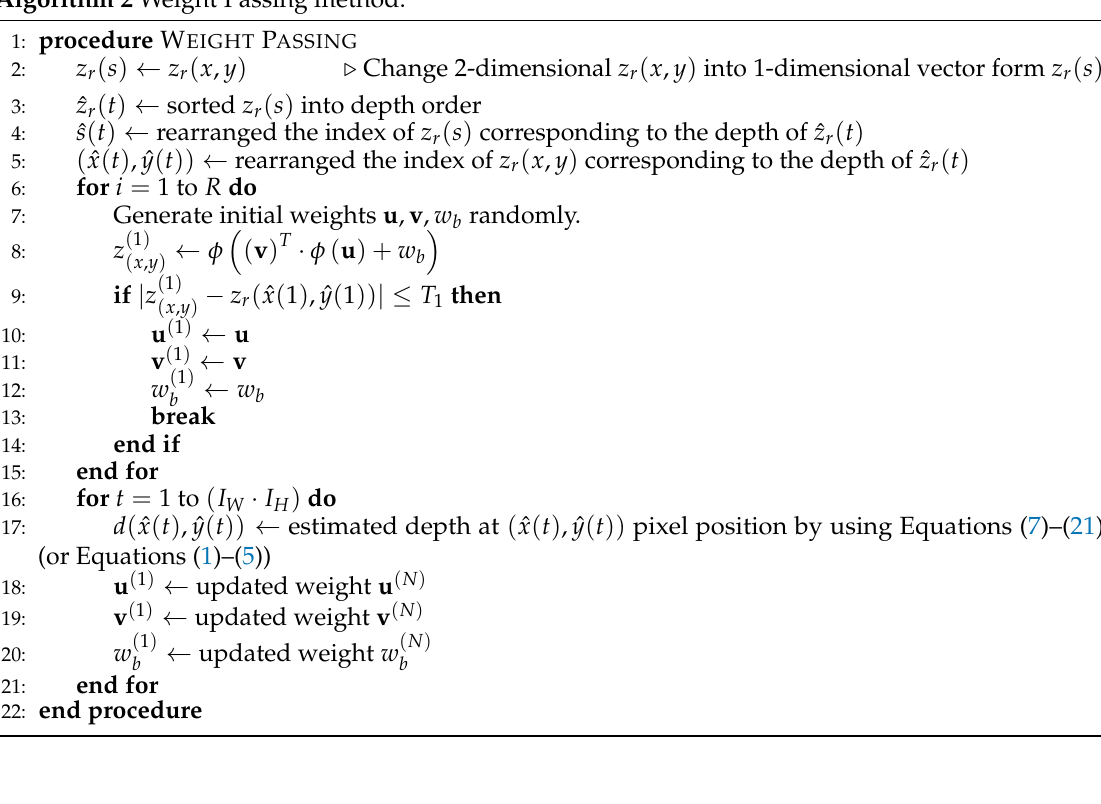
Algorithm 2 Weight Passing method.